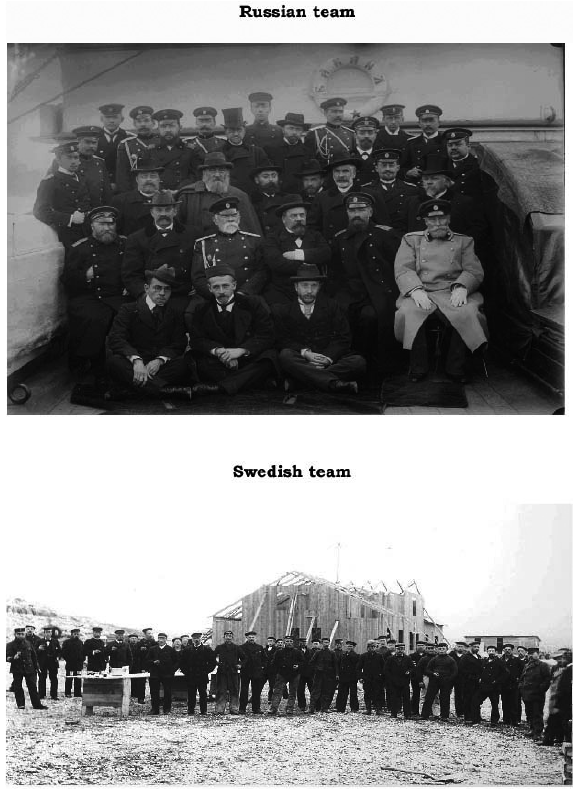
Fig. 2. Above:The Russian scientific team and crew members of the ship Bakan on board the ship. Below: The Swedish expedition team at Treurenberg Bay on occasion of the roof laying